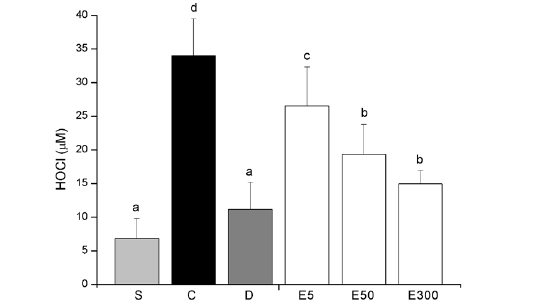
FIGURE 5 - Effect of the treatments on HOCl production from rats’ peritoneal neutrophils. Results are presented as means ± SD of six animals per group. S = saline group; C = carrageenan group; D = dexamethasone group; E5, E50 and E300 = extracts groups. Different letters indicate statistical significance (p<0.05).